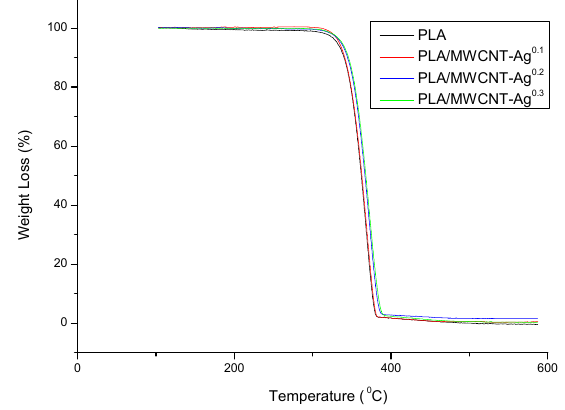
Figure 2. Thermogravimetric analysis (TGA) curves of the PLA and PLA/MWCNT-Ag nanocomposites (DTG curves are showed in Figure S3).